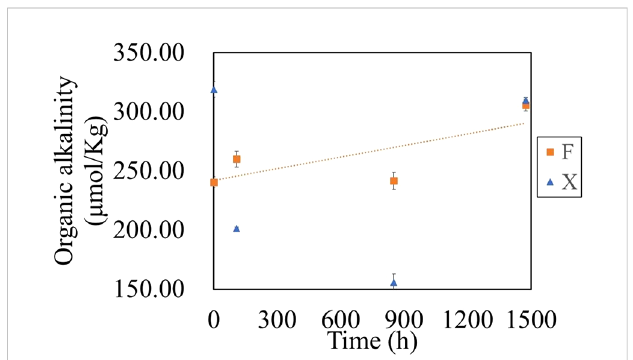
FIGURE 10 Variation of organic alkalinity during the degradation of fresh U. prolifera (X) and decomposed U. prolifera